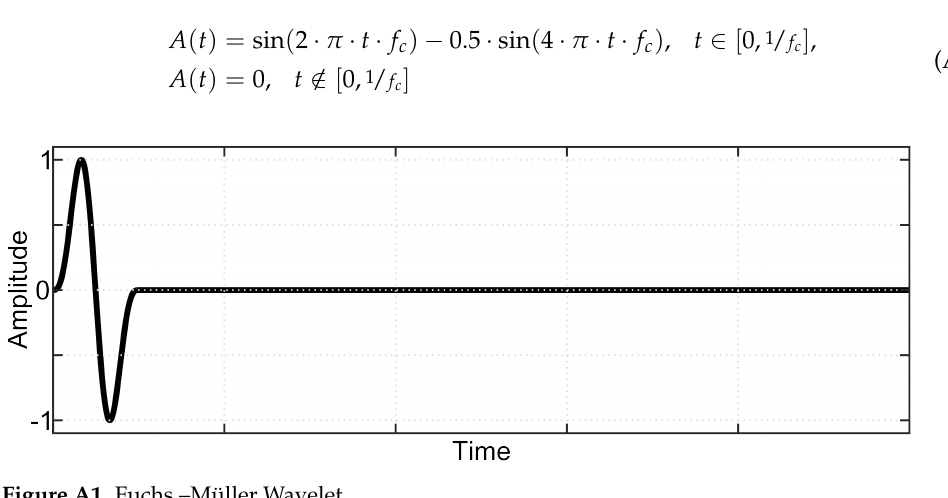
Figure A1. Fuchs –Müller